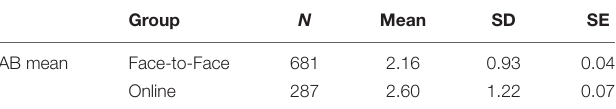
TABLE 6 | Comparing the FLL and OLL